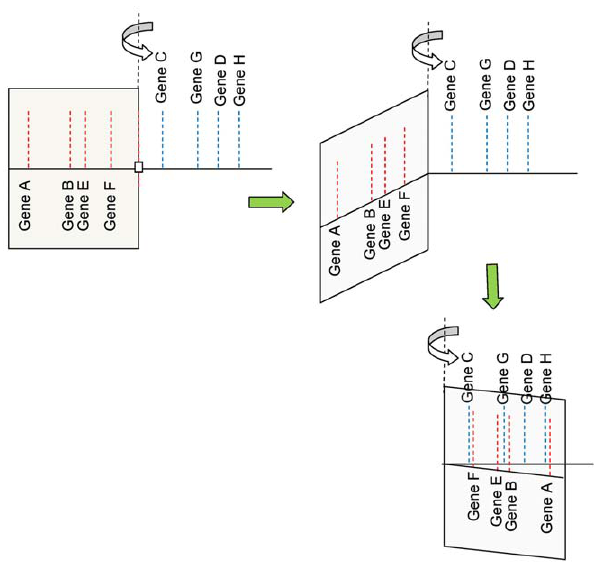
Figure 4. Genes to the left and right of the marker are treated equally (LoGS overview continued). Here we show how left ranked genes and right ranked genes are placed together in the same ranking. were within 50% recombination distance of the linkage peaks, we were left with 319 genes. LoGS ranked the gene sets as shown in Table S3. The five immunological and inflammation gene sets (iCNV-5) again ranked topmost. Following the iCNV-5 immune gene sets, pathways enriched for development (c6 gene set) and